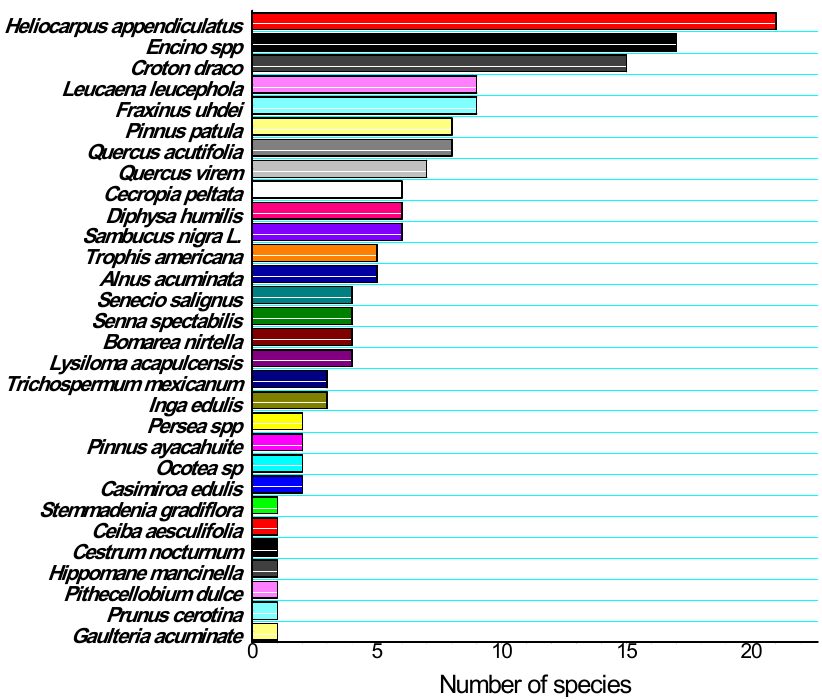
Figure 6. Number of species of the main natural tutors of V. tiliifolia. Figure 5. V. tiliifolia collected in localities of Huatusco, Veracruz, M é xico.